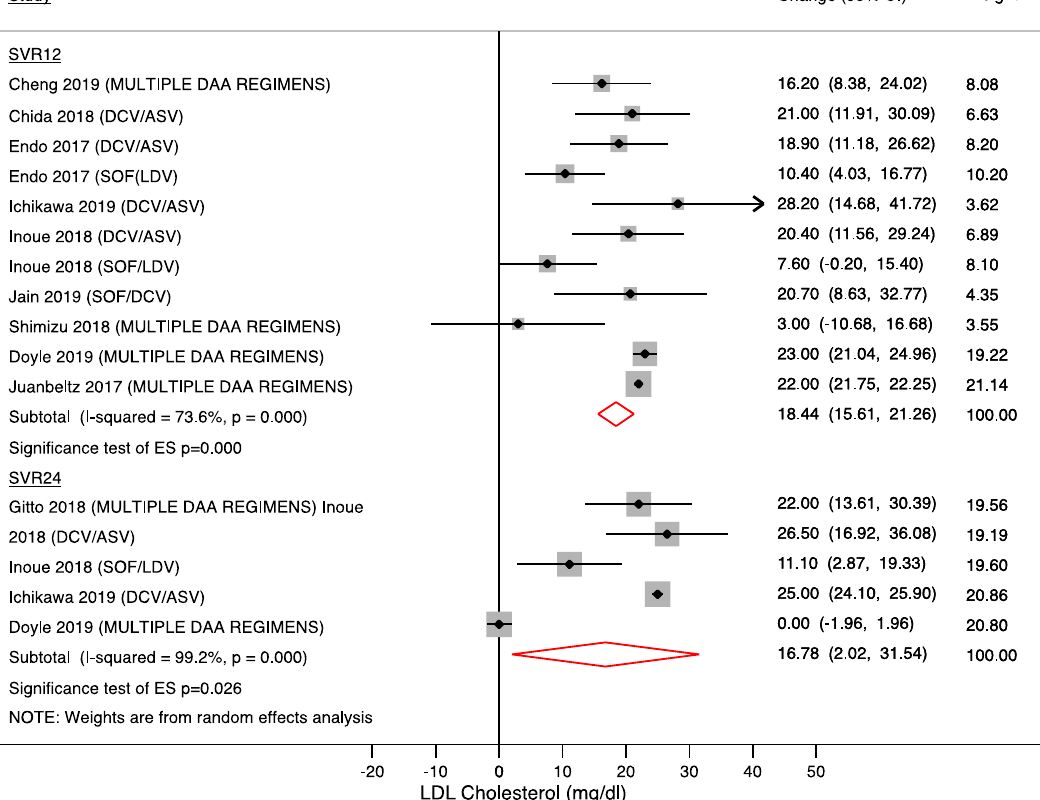
Figure 4. LDL-cholesterol changes after treatment completion. Forest plot for mean difference (MD) and 95% confidence intervals (CI) for each time-point. DCV/ASV daclatasvir/asunaprevir, SOF/LDV sofosbuvir/ ledipasvir, SOF/RBV sofosbuvir + ribavirin, SOF/DCV sofosbuvir + daclatasvir, SVR12 Sustained virological response at 12 weeks, SVR24 Sustained virological response at 24